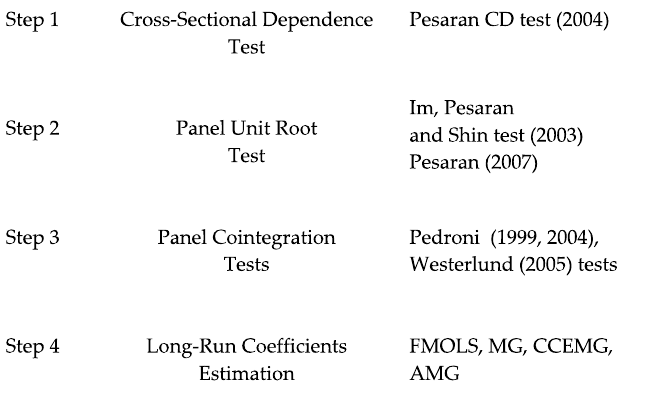
Figure 1. The model estimation method. Notes: FMOLS—Fully Modified Ordinary Least Squares test; MG—Pesaran and Smith Mean Group estimator; CCEMG—Pesaran Common Correlated Effects Mean Group estimator; AMG—Augmented Mean Group estimator.